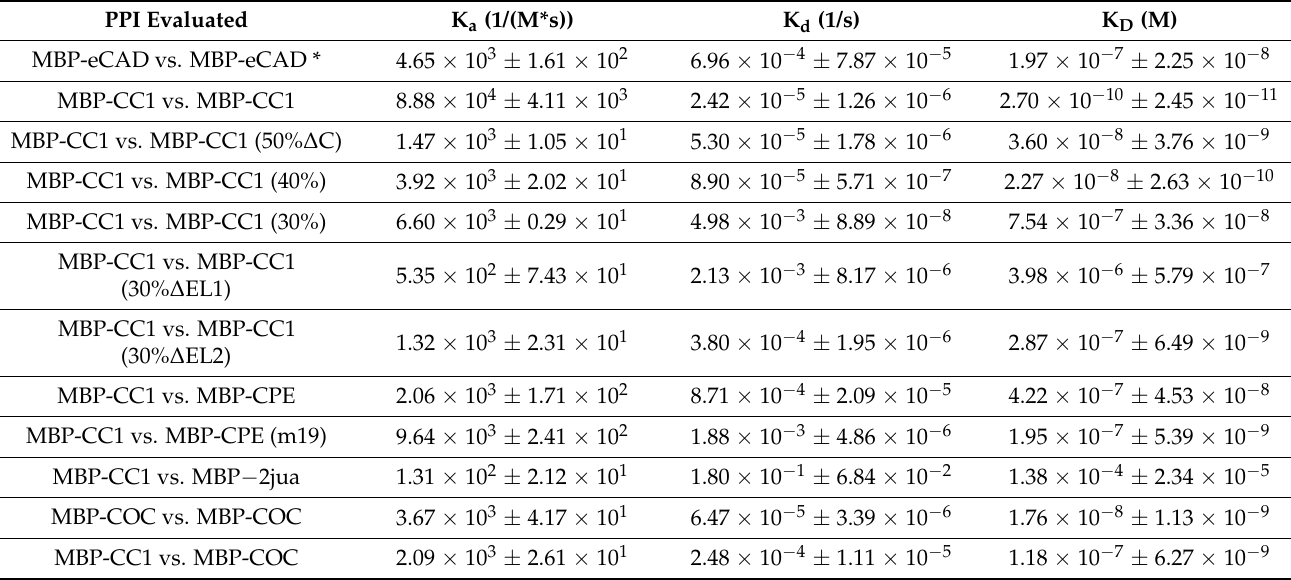
Table 1. Surface Plasmon Resonance (SPR) studies of chimeric claudins and other relevant proteins. (*) MBP-eCDA experiments are carried out in the presence of 3 mM